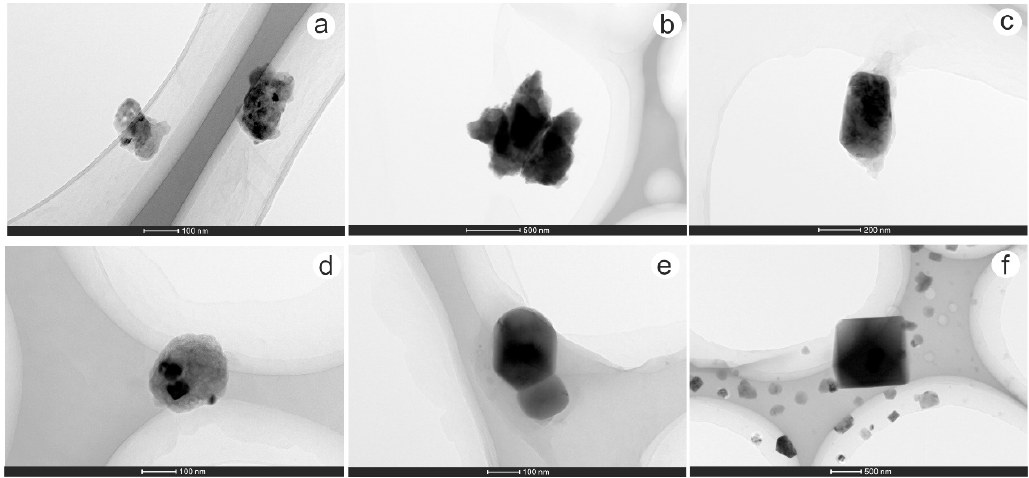
Figure 7. TEM images of Ca-, Ba-, Ti-, and Na-bearing nanoparticles in soils over the studied gold deposit; ( a ) Ca-bearing particles; ( b ) Ca-bearing particles; ( c ) Ba-bearing particles; ( d ) Ti-bearing particles; ( e ) Ti-bearing particles; ( f ) Na-bearing particles.